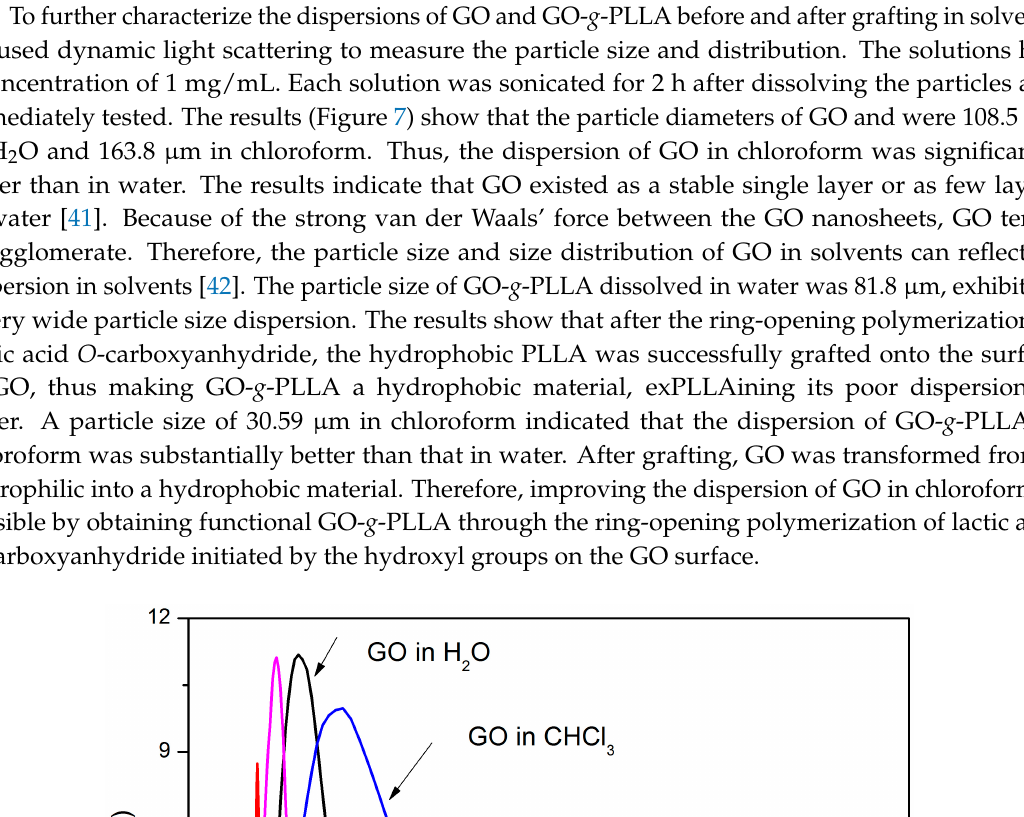
Figure 8. Dispersions of GO and GO- g -PLLA in chloroform.